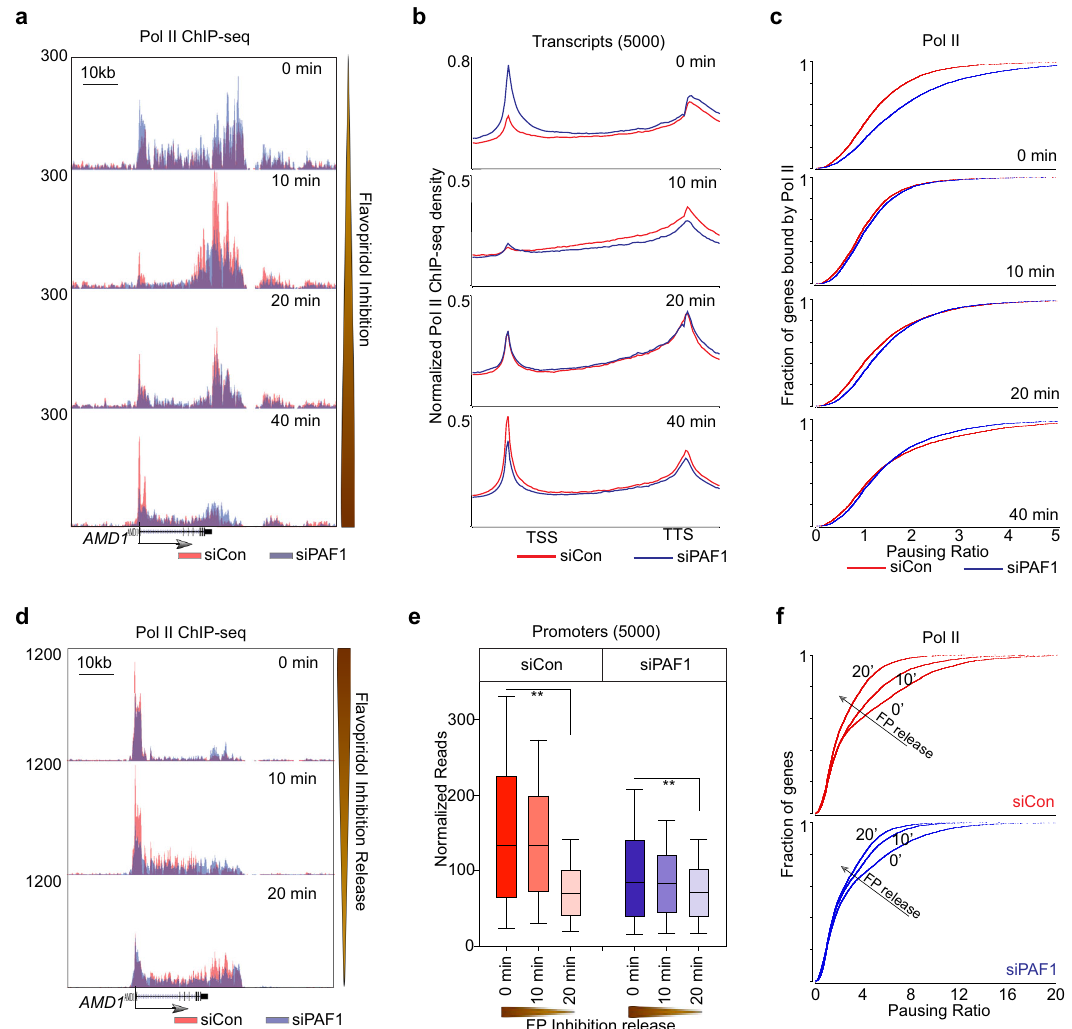
Fig. 4 PAF1 is required for Pol II transcriptional recycling in human cells. a Genome Browser views illustrating Pol II (Ser2) ChIP-seq signal changes in LNCaP-abl cells treated with siControl or siPAF1 during Flavopiridol inhibition. b Average Pol II (Ser2) ChIP-seq signal densities over the scaled 5000 human RefSeq genes in LNCaP-abl cells. c Pausing ratio of Pol II (Ser2) was calculated, sorted, and plotted in LNCaP-abl cells with timed FP inhibition. d Genome Browser views illustrating Pol II (Ser2) ChIP-seq signal changes in LNCaP-abl cells treated with siControl or siPAF1 during release from Flavopiridol inhibition. e Box plots show Pol II (Ser2) ChIP-seq signal densities in 5000 promoter regions during timed FP inhibition release. Box plots show median (center), 25th/75th percentiles (box bounds), 10th/90th percentiles (whiskers). The values beyond the whiskers are not shown in the boxplot. p -values were calculated using one-way ANOVA on ranks, ** p <0.001. f Pausing ratio of Pol II (Ser2) was calculated, sorted and plotted in LNCaP-abl cells during timed FP inhibition release. Source data are provided as a Source data fi